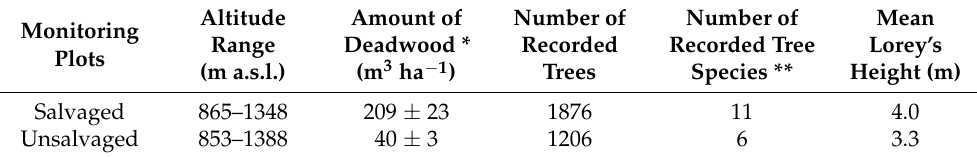
* Lying and standing dead trees with a diameter of 7 cm and more [39]. ** Only species with a minimum of 10 individuals recorded at all monitoring plots were considered, specifically: Salvaged plots—common rowan, European larch, goat wil- low, Norway spruce, Scots pine, silver birch, black alder, common alder, sycamore maple, silver fir and downy birch. Unsalvaged plots—common rowan, European larch, goat willow, Norway spruce, Scots pine and silver birch.